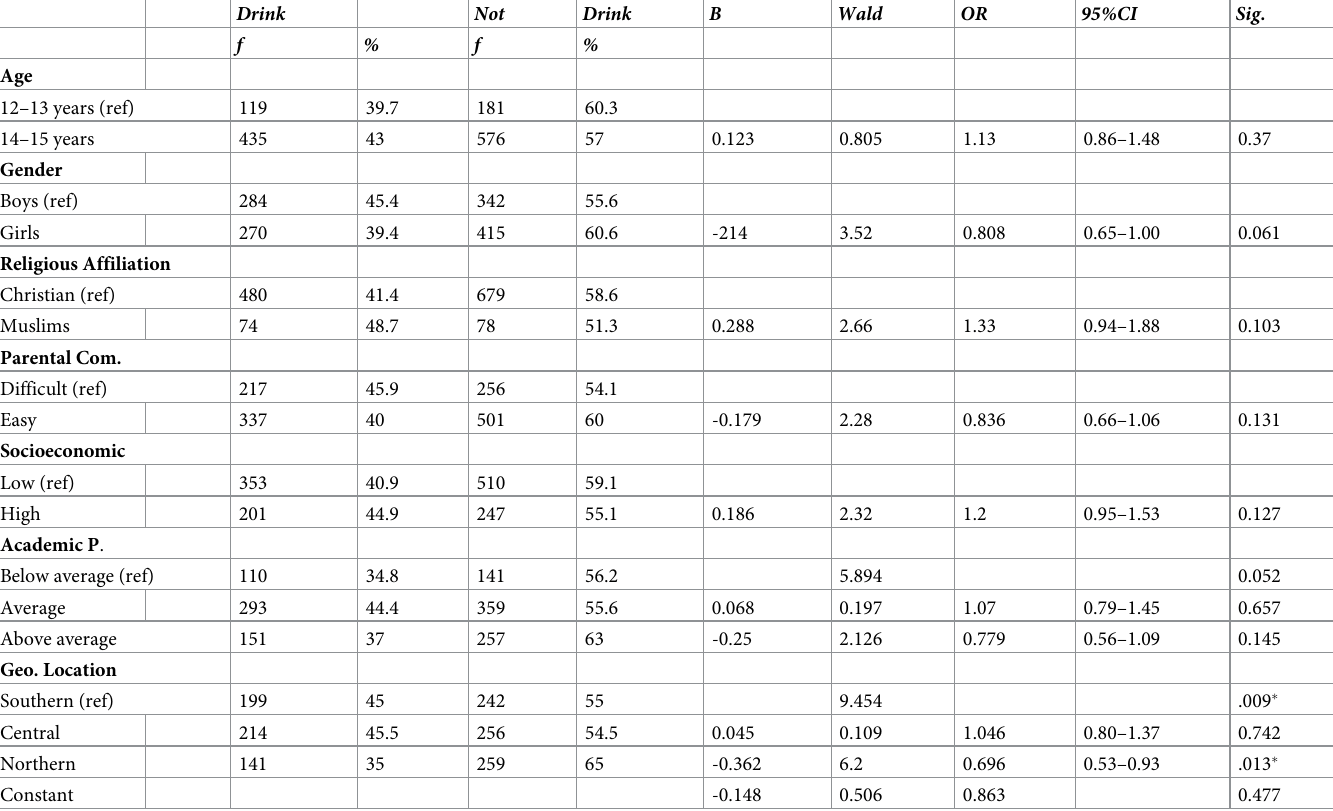
Table 2. Binary logistic regression of socio-demographic predictors of alcohol drinking among school going